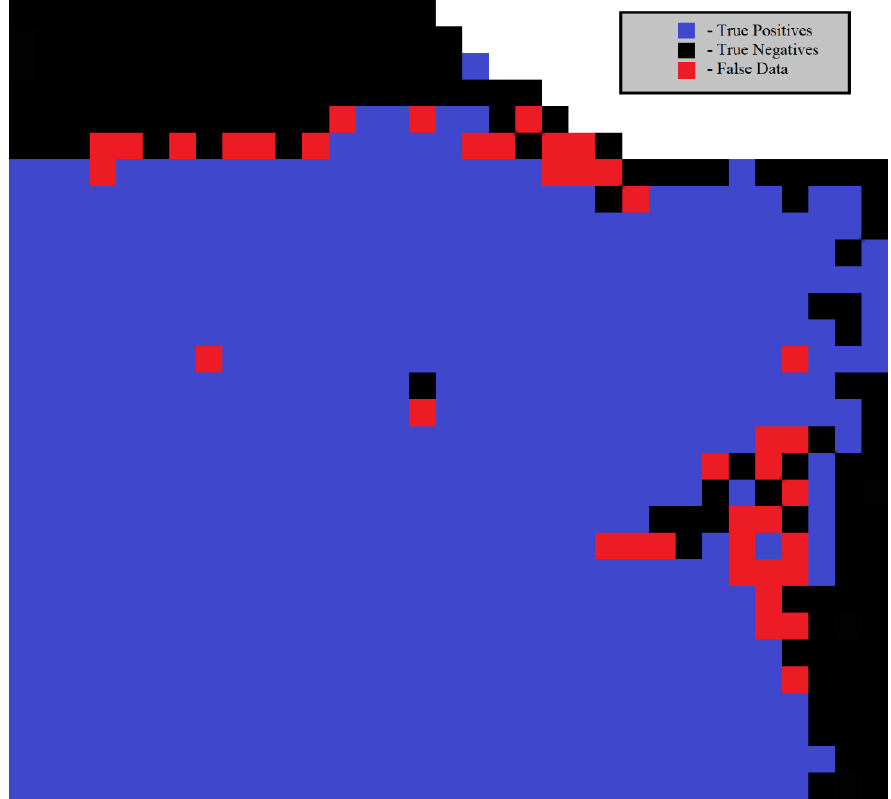
Figure 12. Some error analysis concluded that most False Positives or Negatives, indicated in red, are predominately located at the edge of the burn area.